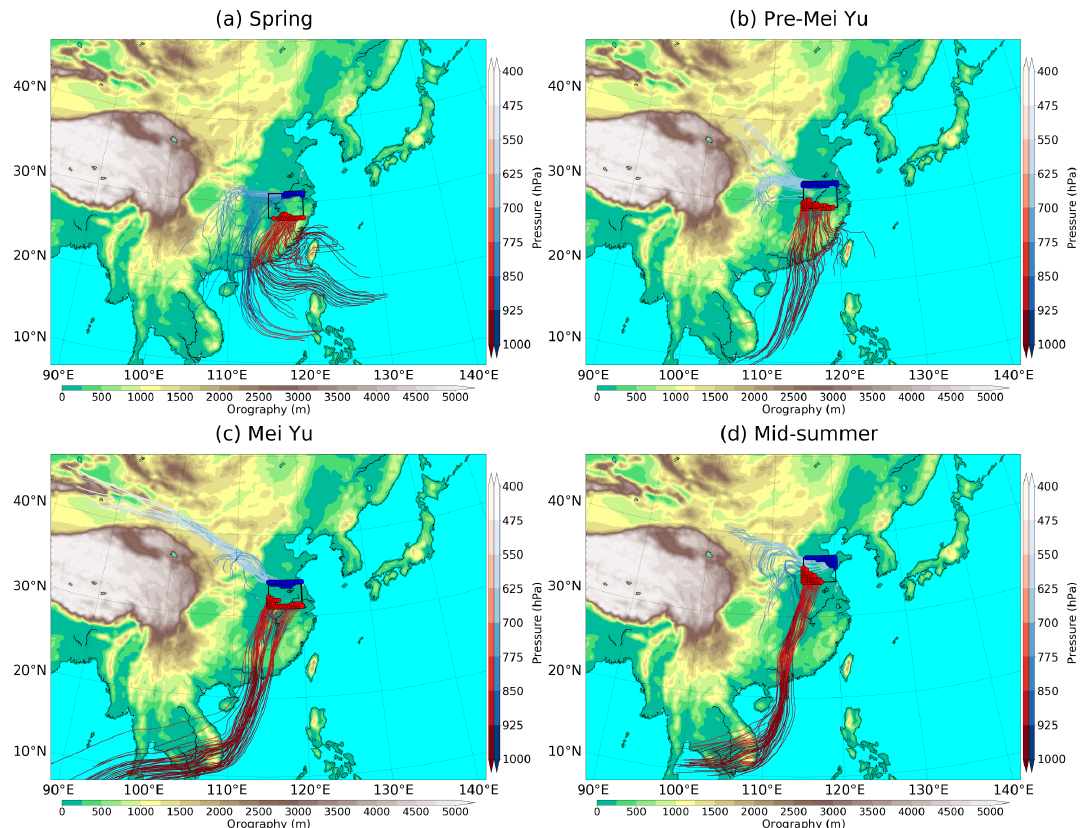
Figure 11. Warm (red) and cool (blue) Lagrangian trajectories starting at 06:00UTC on (a) 7 May, (b) 7 June, (c) 27 June, and (d) 17 July of the 1979–2018 climatology (Sect. 2.3), computed backward for 168h. The black quadrilateral indicates the selection domain (see text for more details on the selection process). Colour shading indicates the pressure of trajectories at each position, and red and blue dots within the small domain indicate the starting points of the selected trajectories. The dekads representing the four stages of EASM progression (first dekad of May, first dekad of June, third dekad of June, second dekad of July, respectively) are selected according to Fig. 3. Data from ERA5 1979–2018